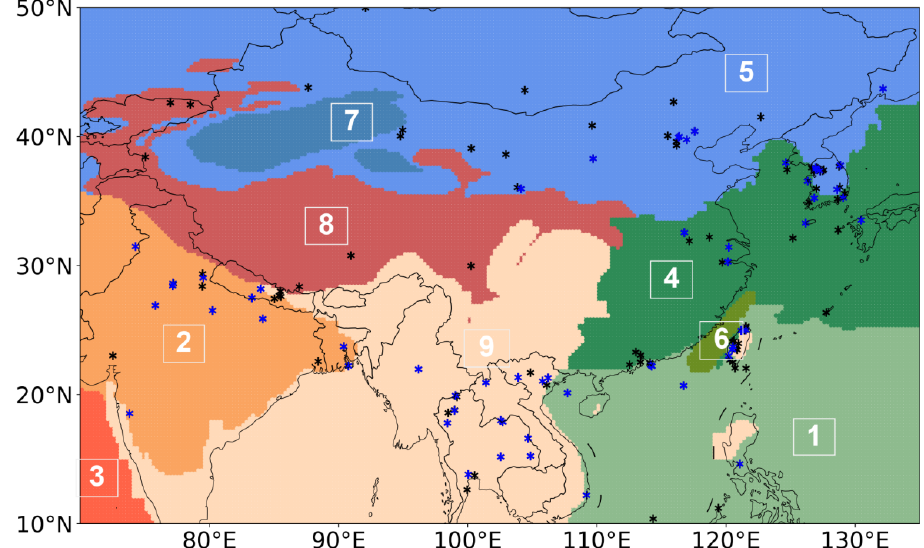
Figure 4. The nine meteorological states identified with the hierarchical clustering algorithm are highlighted with different colors. The asterisks indicate the locations of the AERONET sites with the blue ones showing the sites with enough valid data for analysis.